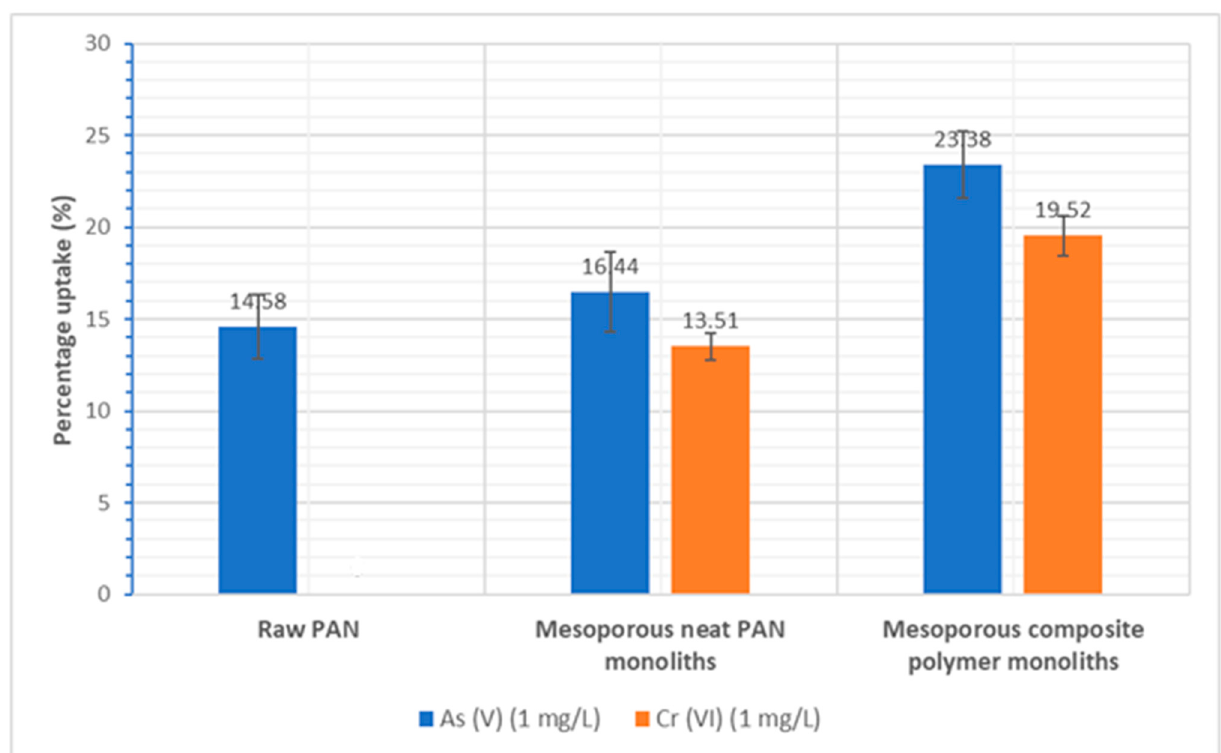
Figure 10. The percentage recovery of both toxic elements (As(V) & Cr(VI)) from 1 mg·L − 1 prepared standard solutions by the three different polymer materials with error bars included.